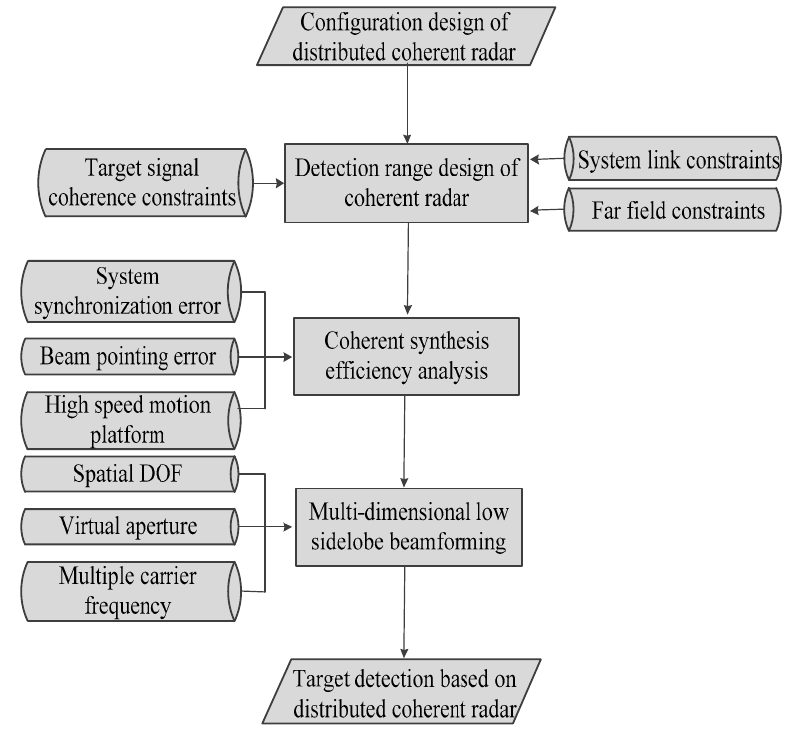
Figure 3. Flowchart of dynamic coherent radar designing method.